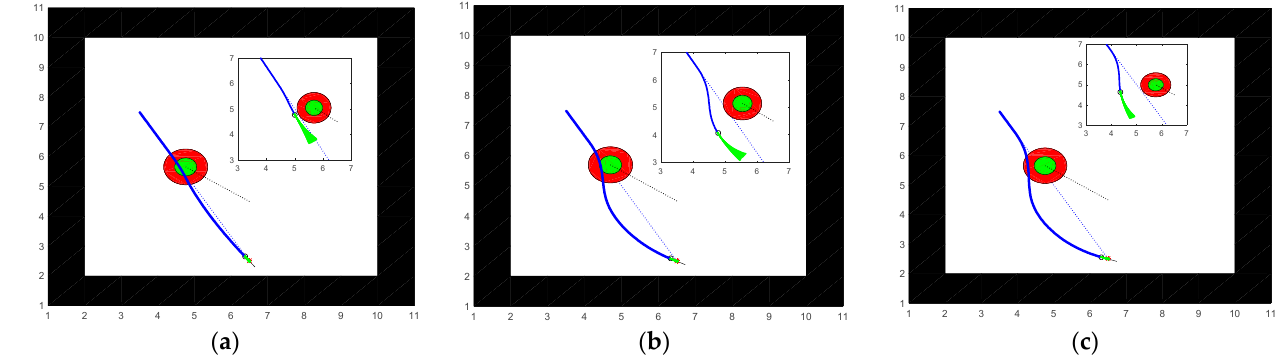
Figure 22. Comparison of path planning results for unknown dynamic environment 2; ( a ) Chi et al. [7]; ( b ) Improved algorithm [7]; and ( c ) This